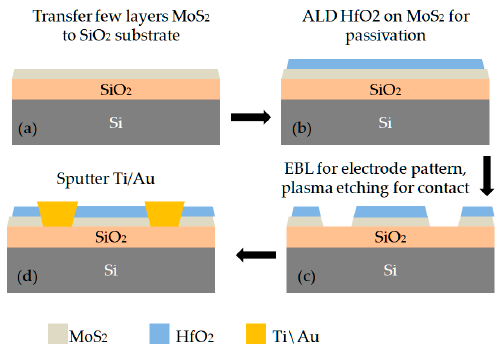
Figure 3. Fabrication process of edge-contacted 2D material back-gate FET ( a ) Transfer MoS2 to substrate; ( b ) ALD HfO2 for passivation; ( c ) Etching for contact; ( d ) Sputter Ti/Au.